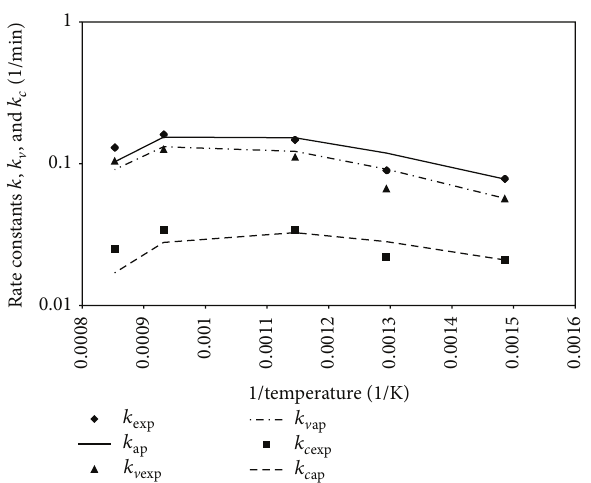
Figure 5: Comparison of simulated rate constants 𝑘 𝑘 𝑐 app as per deactivation model with the experimental results 𝑘 𝑘 V exp . 𝑐 exp forweightlossofnewspaper,volatile,andcharformation, respectively.